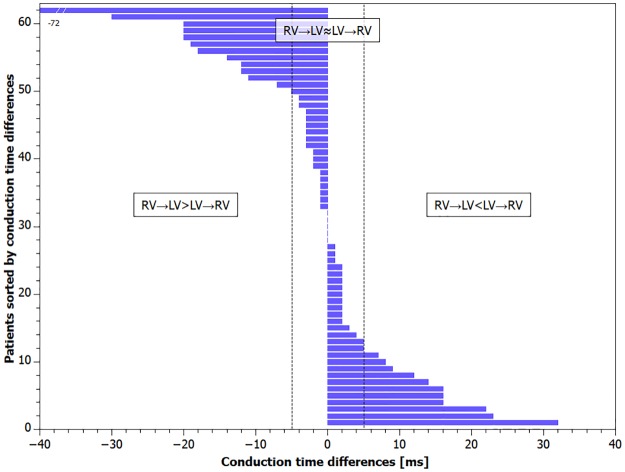
Differences in interventricular conduction times sorted by differences value (whole study group N = 62).Dashed line define group borders: Group RV→LV≈LV→RV—bidirectionally comparable conduction with differences ≤ ±5 ms (n = 39). Group RV→LV>LV→RV—negative difference value—faster conduction from the left ventricle to the right ventricle (n = 12) and Group RV→LV<LV→RV—positive difference value—faster conduction from the right ventricle to the left ventricle (n = 11). * Conduction time difference was -72 ms.